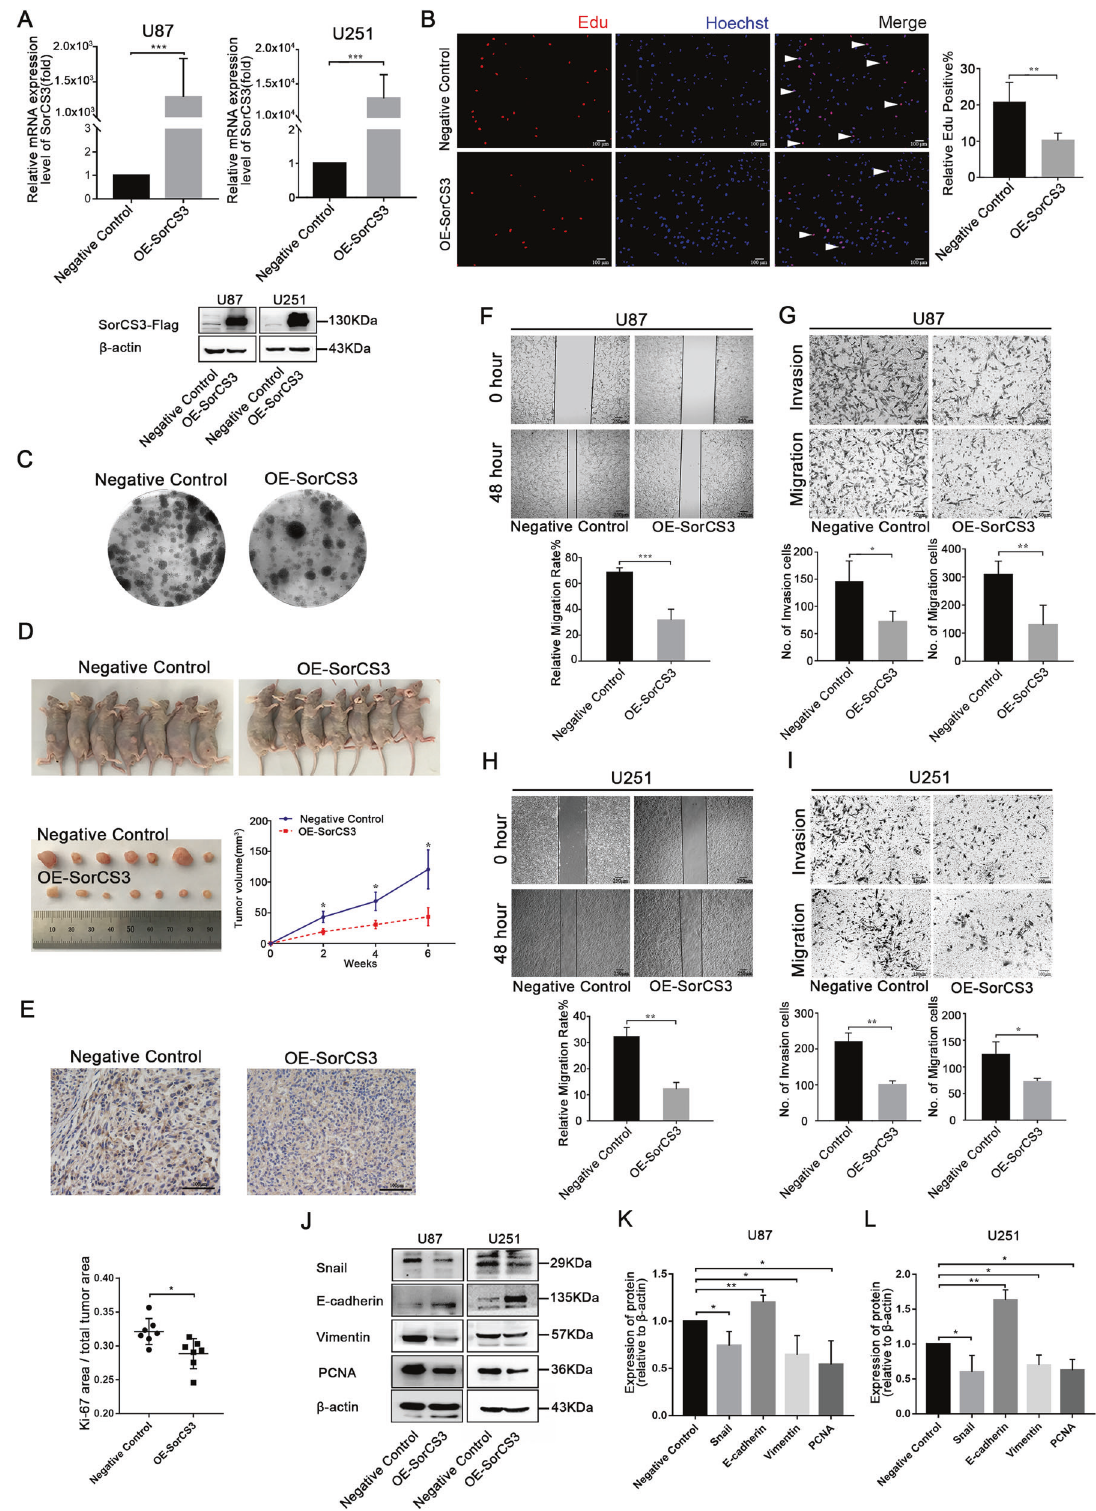
Fig. 2 Overexpression of SorCS3 inhibits the migration, invasion, and proliferation of the glioma cells. A After transfection with the pCMV3- SorCS3-Flag plasmid, the expression levels of SorCS3 were examined through real-time PCR and Western blotting, using β -actin as an endogenous control. B Cell proliferation was determined by EdU staining and EdU incorporation was calculated as EdU + cells/total cells, quanti fi ed by ImageJ. Red was stained for proliferation (EdU + ), blue was stained for nucleus. C Colony formation assay for assessing the cell proliferation of SorCS3 overexpression. D Image of tumours in nude mice bearing U87 cells treated with overexpression of SorCS3 and control. Tumour volume were measured ( n = 7). E Immunohistochemical staining of Ki-67 expression in xenograft tumour tissues ( n = 7). F , H Effect of SorCS3 overexpression on wound healing of U87and U251 cells. G , I Transwell assays used to determine the in fl uence of SorCS3 overexpression on the migratory and invasive abilities of U87 and U251 cells. J – L Western blot analysis of proliferation and EMT associated marker after SorCS3 overexpression. Data are shown as mean ±S.D. including three independent experiments. * p <0.05; ** p <0.01; *** p <0.001. Cell Death and Disease (2022)